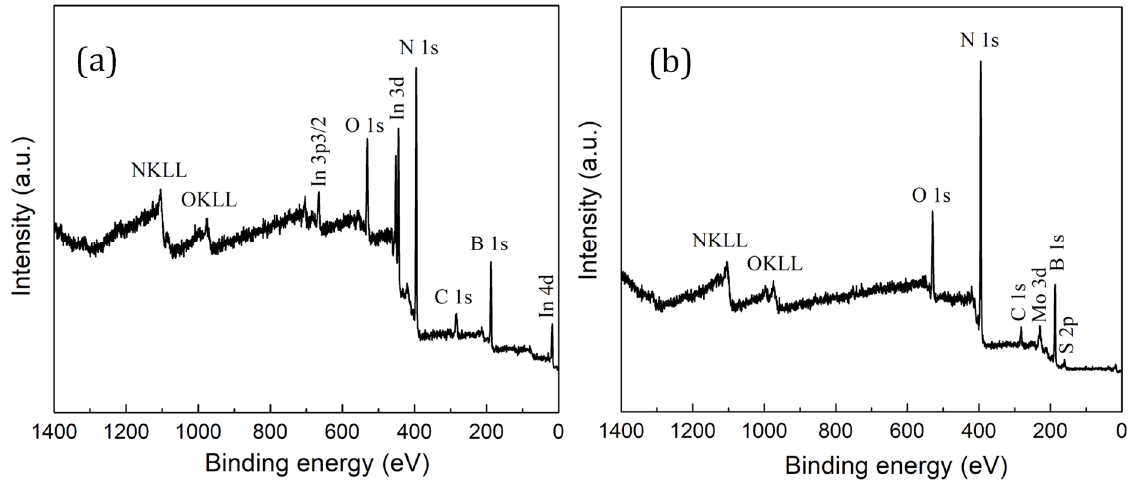
Figure 4. Survey spectra of h -BN x O y ( a ) and a -MoS x O y / h -BN x O y materials ( b ). High-resolution XPS spectra of the h -BN x O y and a -MoS x O y / h -BN x O y materials are depicted in Figure 2d–k. The XPS B 1s spectrum of h -BN x O y was deconvoluted into three components: B–O (192.8 eV), BNO (191 eV), and BN (190.2 eV) [50]. The XPS N 1s